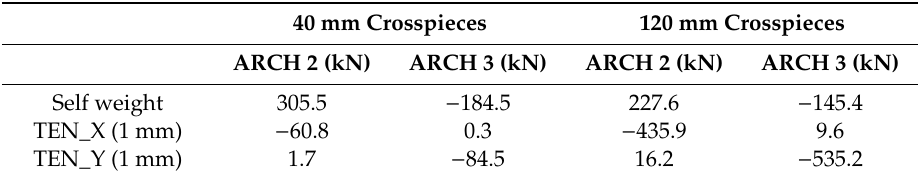
Table 15. The influence matrix loads on arches 2 and 3.